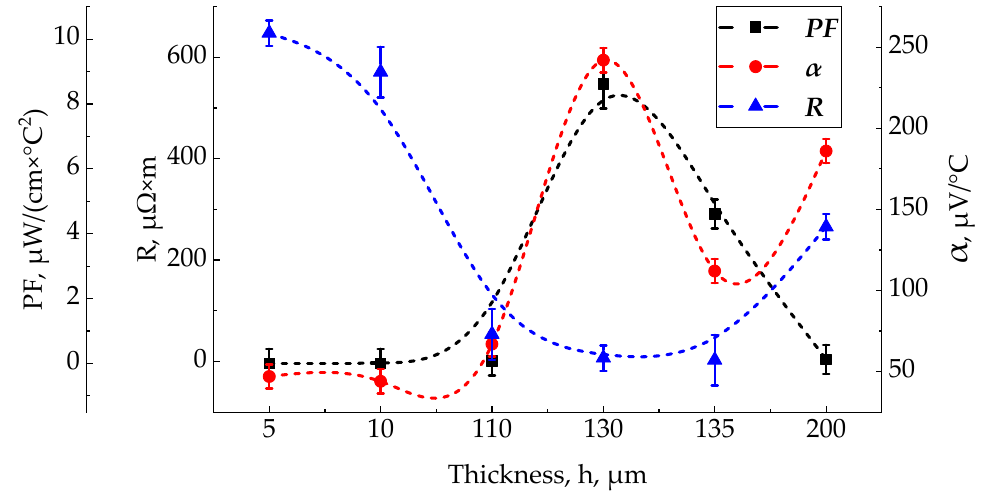
Figure 9. Plot of the main properties, α , R, PF versus the thickness of a film, h.